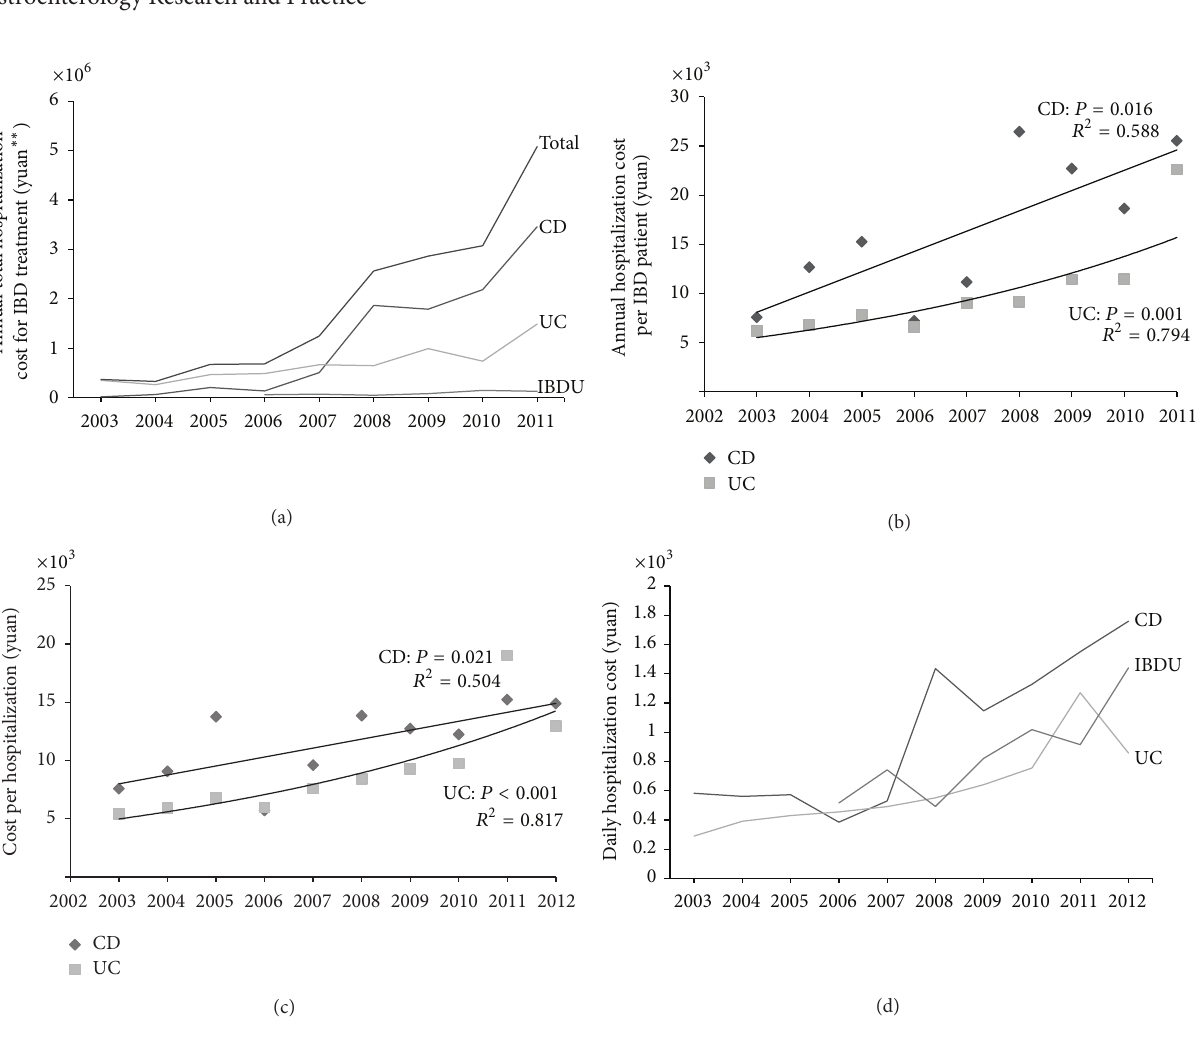
Figure 3: Alterations of hospitalization costs. (a) The variation trend of annual total hospitalization cost for IBD treatment from 2003 to 2011; (b) linear regression line of annual hospitalization cost per CD patient and exponential regression curve of annual hospitalization cost per UC patient from 2003 to 2011; (c) linear regression line of the cost per CD hospitalization and exponential regression curve of the cost per UC hospitalization from 2003 to 2012; (d) daily hospitalization